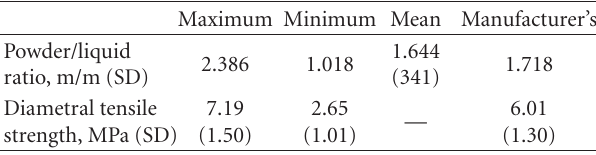
Table 1: Extreme powder/liquid mixing ratios & corresponding mean diametral tensile